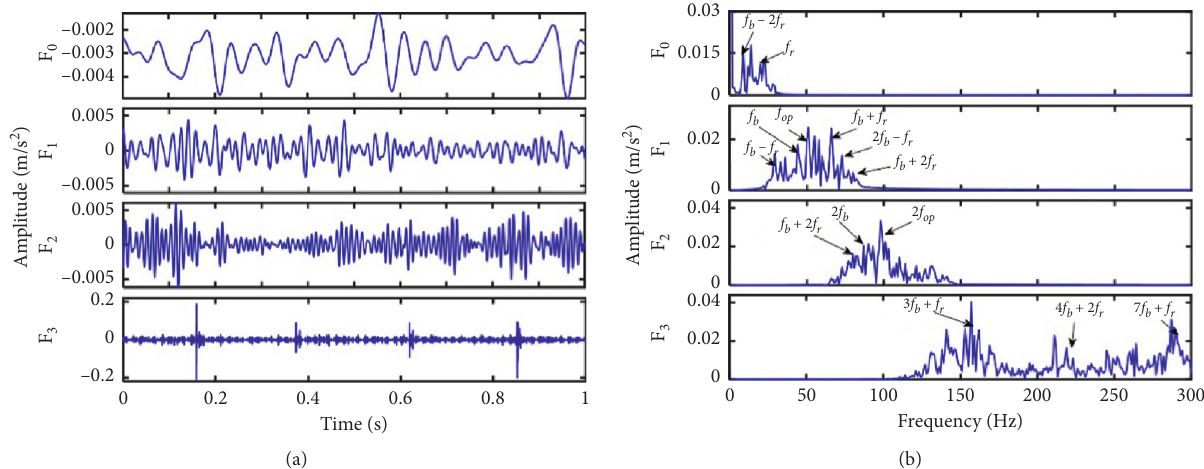
Figure 11: Rolling element fault characteristics: (a) modal components of the rolling element fault signal using EWTand (b) their associated